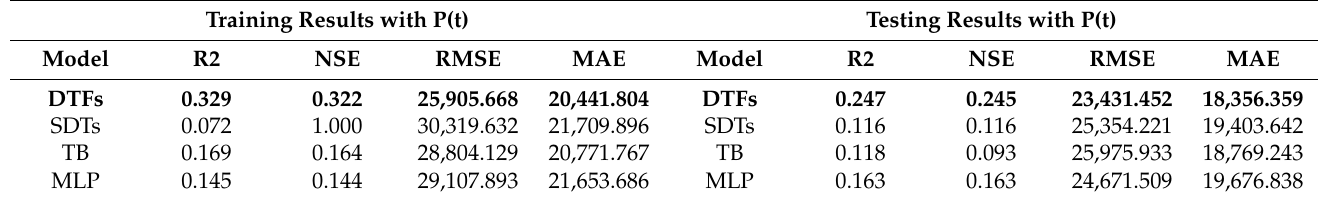
Table 3. Training and testing results with Q(t) of different data mining techniques.